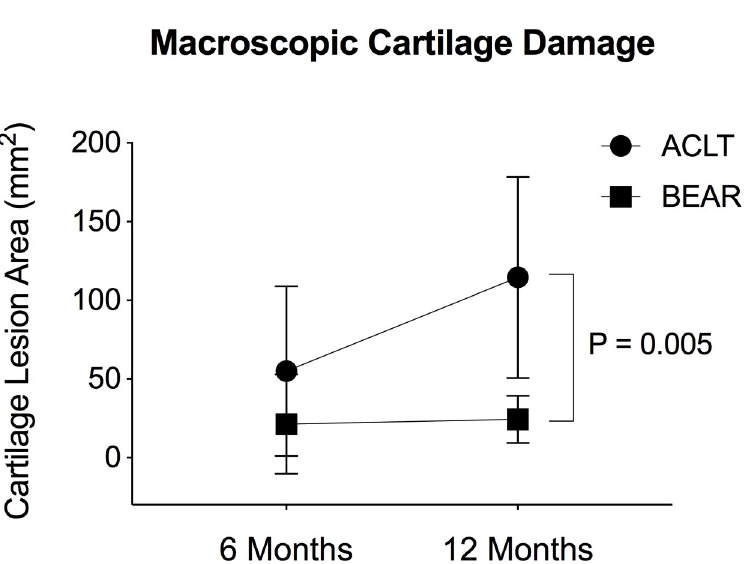
Fig 1. Development of macroscopic cartilage damage following ACL transection. Total cartilage lesion area at 6 and 12 months after untreated ACL injury (ACLT) and bridge-enhanced ACL repair (BEAR). Data is presented as Mean ± SD. P value is derived from a one-way ANOVA with posthoc Bonferroni correction for multiple comparisons (adopted and modified with permission from Murray MM and Fleming BC, Am J Sports Med 2013 [12]) Macroscopic cartilage damage was assessed by measuring the cartilage lesions across the femoral condyles and tibial plateau in medial and lateral compartments using India ink staining and calipers [12].